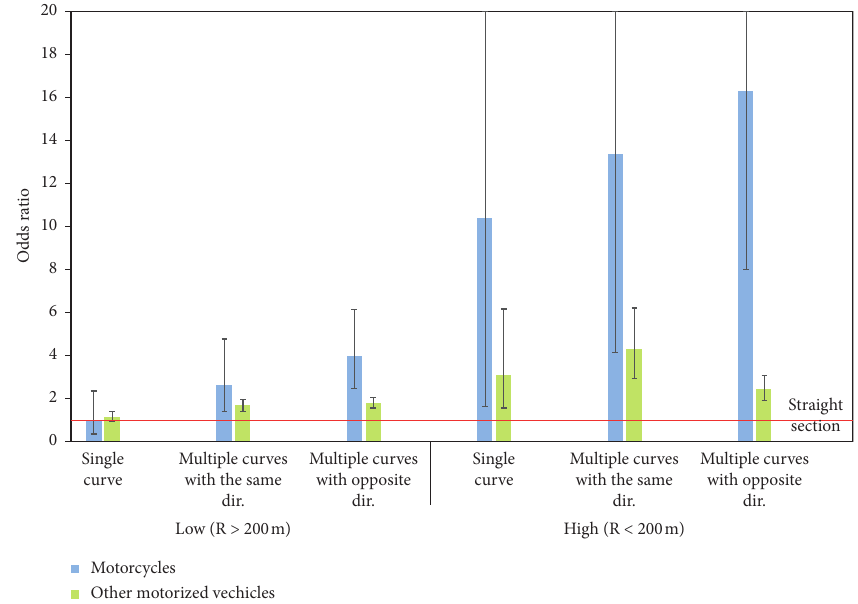
Figure 6: Odds ratio for horizontal curvature. Motorcycles and other motorized vehicles (including data from